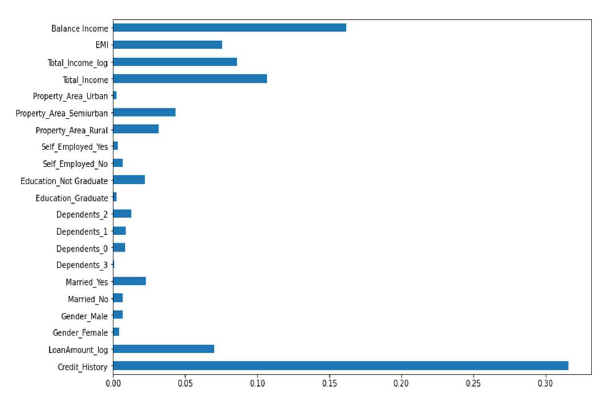
Fig 5. Feature importance predicting the target